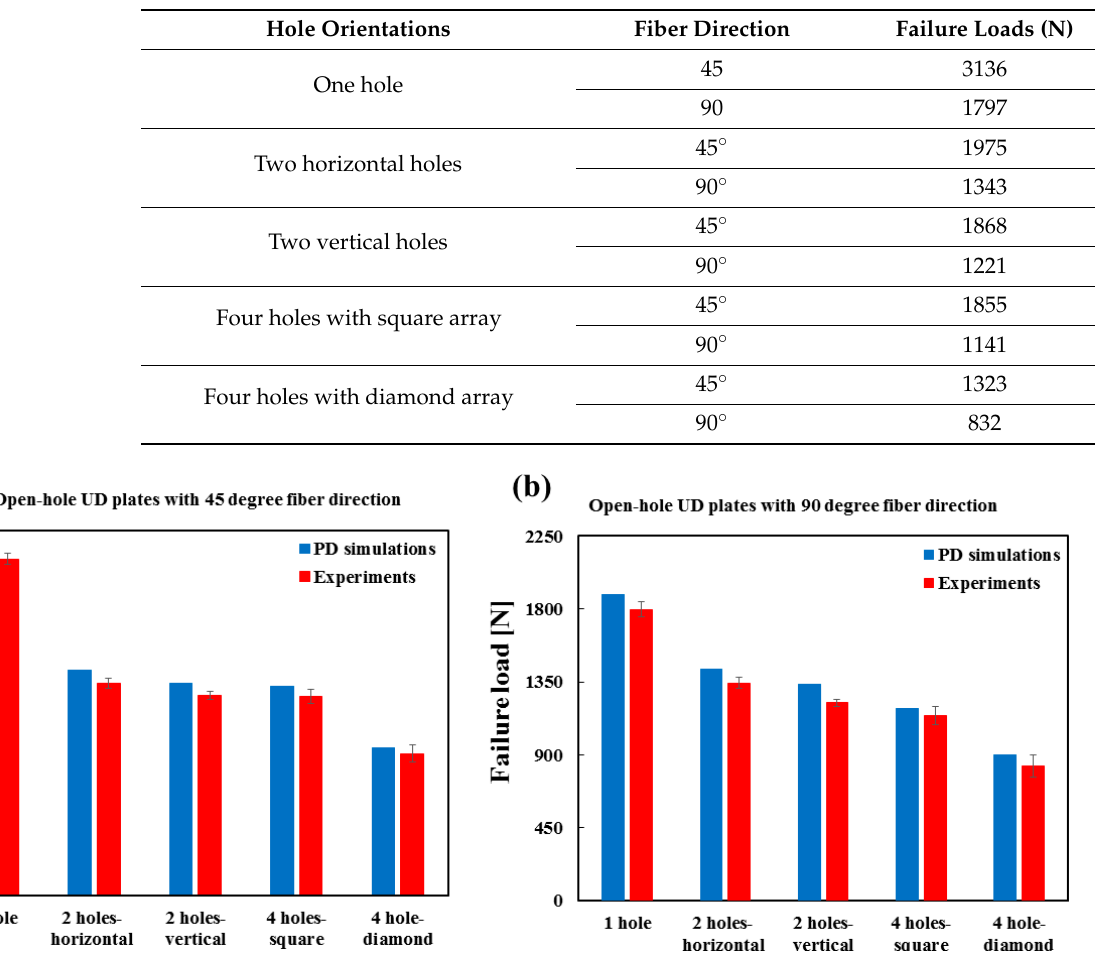
Figure 9. Comparison of failure loads of Peridynamic (PD) simulations and experiments.